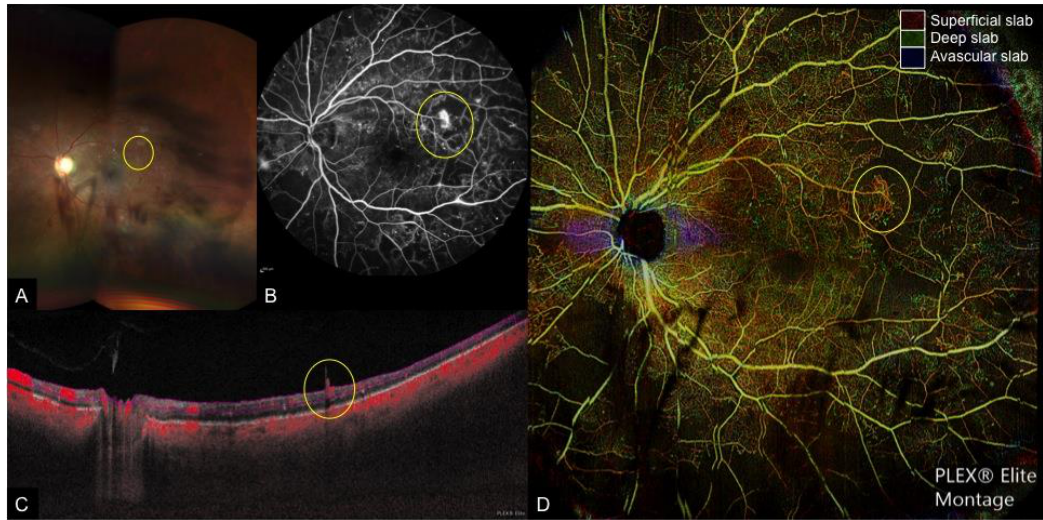
Figure 1. Multi-modal imaging of a case of proliferative diabetic retinopathy and vitreous hemorrhage. ( A ): Wide-field fundus photograph depicting scattered retinal hemorrhages with vitreous hemorrhage obscuring the temporal and inferior view of the retina, ( B ): Fundus fluorescein angiography (FA), ( C ): Cross-sectional optical coherence tomography angiography (OCTA) with flow indicated in red, and ( D ): Color-coded depth-resolved en face OCTA montage, which is a fusion image of the superficial (red), deep (green), and avascular (blue) en face OCTA slabs. New vessels (yellow circle) are seen on FA as areas of leakage and on cross-sectional OCTA as areas of flow extending from the retinal surface into the vitreous, which corresponds to fronds of vessels on en face OCTA .